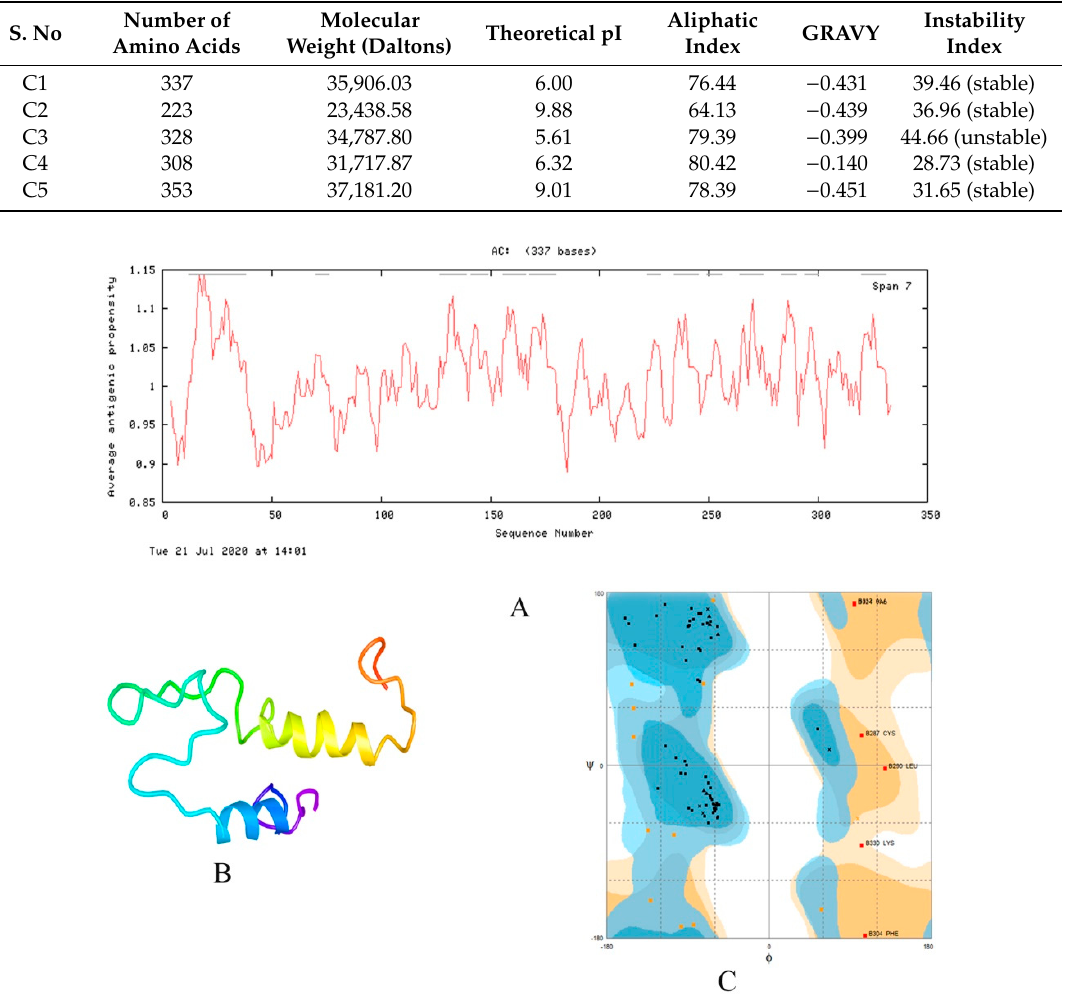
Figure 3. ( A ) The average antigenic propensity (1.0098) of vaccine construct-1 (C-1). Grey lines above the graph show regions with increased antigenicity. ( B ) 3D structure of the final vaccine, which contains two right-handed alpha helices (DodgerBlue and Yellow) and coil and random coils (DeepSkyBlue, LawnGreen, and OrangeRed). ( C ) Ramachandran plot of the modeled vaccine construct. The number of residues in favored regions were 63 (77.8%), 12 were in allowed (14.8%) and 6 (7.4%) were outliers.